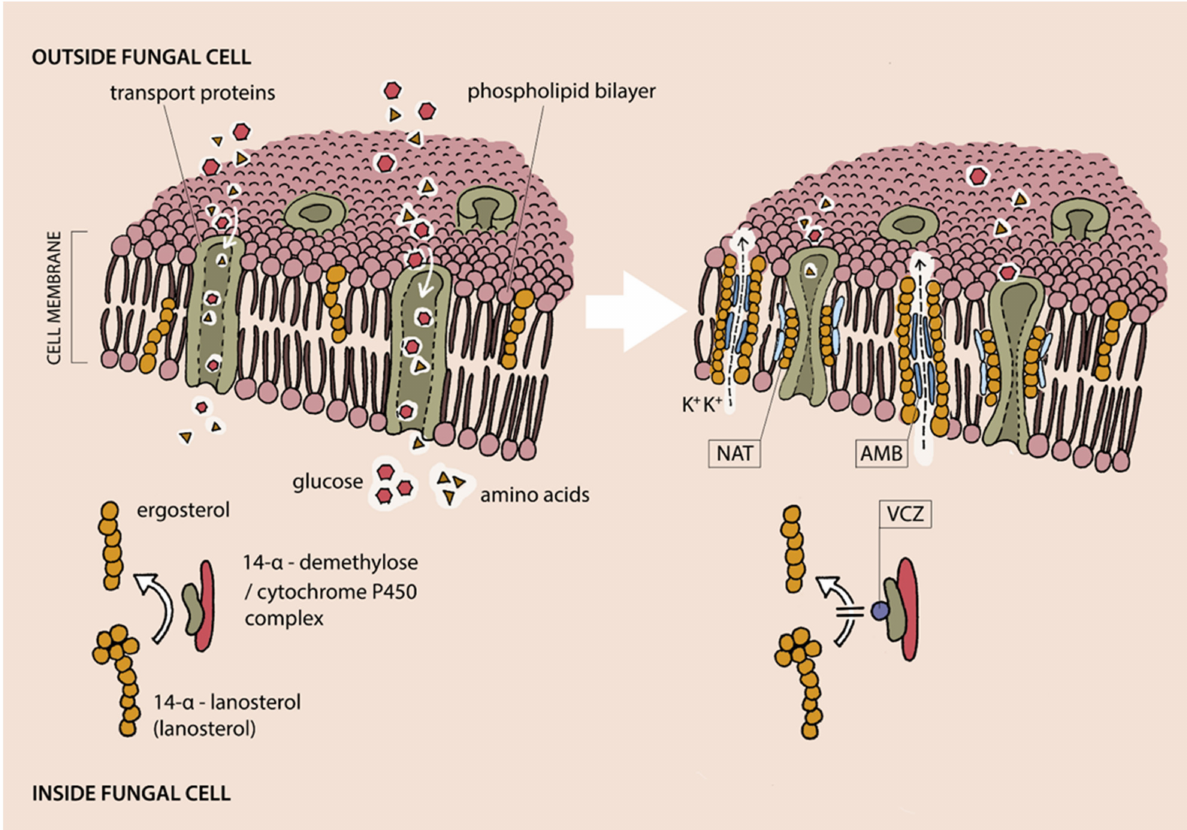
Figure 4. Mechanisms of action of the most commonly used antifungals. AMB—amphotericin B, NAT—natamycin, VCZ— voriconazole. AMB binds to the cell membrane ergosterol, which results in the formation of pores and an increase in the membrane permeability. Binding of NAT to the ergosterol leads to inhibition of glucose and amino acids transport trough adequate membranes transporters. VCZ blocks 14- α -demethylase/cytochrome P450 complex, which leads to a decrease in transformation of 14- α -lanosterol to ergosterol and, as a result, destabilization of the cell